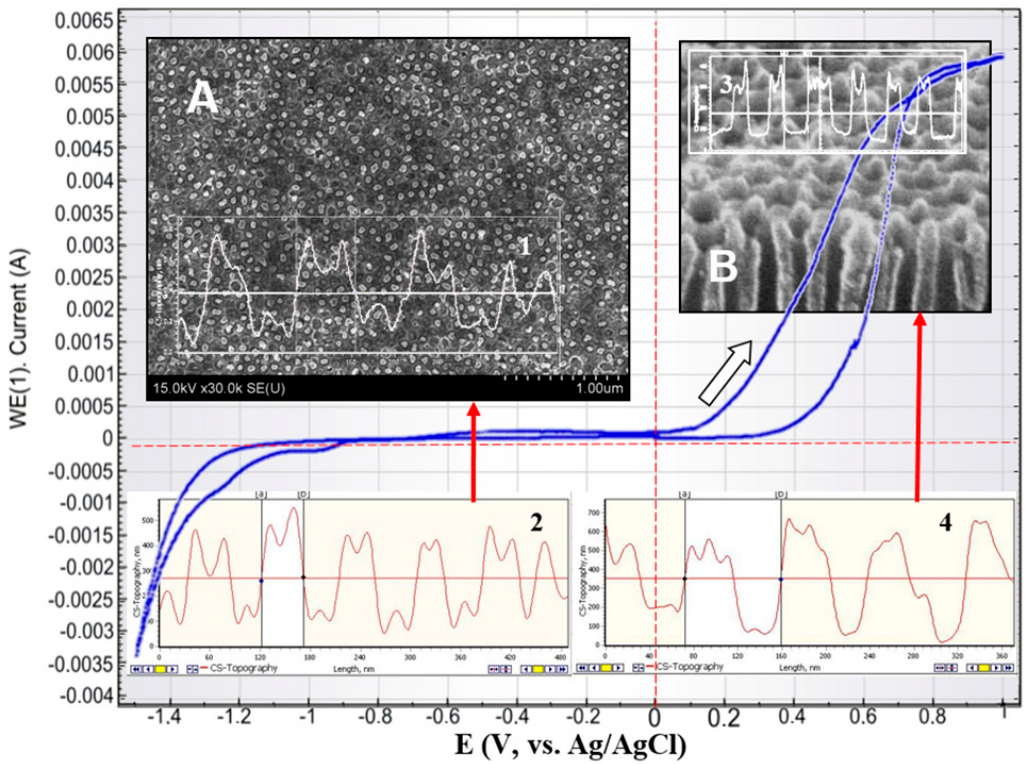
Figure 8. Cyclic voltammogram of the Ti/PAAT/Ni sample in the 0.9% aqueous solution of NaCl at a potential scanning rate of 0.1 V/s. In the insets: ( A )—top view and AFM-profiles (1,2) of the experimental sample (NiNPs in PAAT) after alumina partial etching, ( B )—cross-section views and AFM-profiles (3,4) of the experimental sample (PAAT) before NiNPs deposition into Al 2 O 3 .